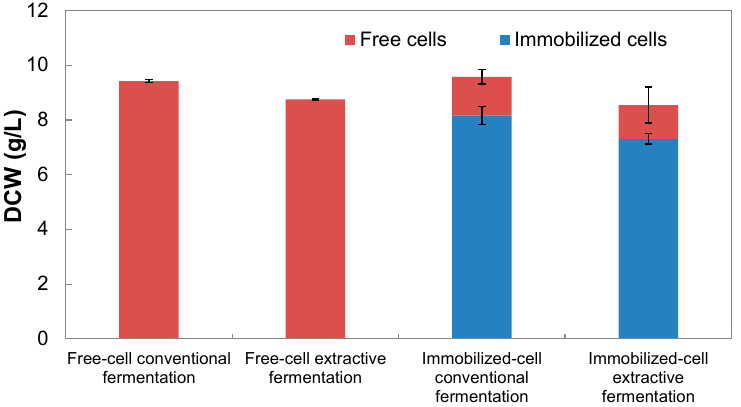
Figure 2. Effects of cell immobilization and Triton X-100 on cell growth. Leaked cells from the beads in immobilized-cell fermentation were recorded as free cells.